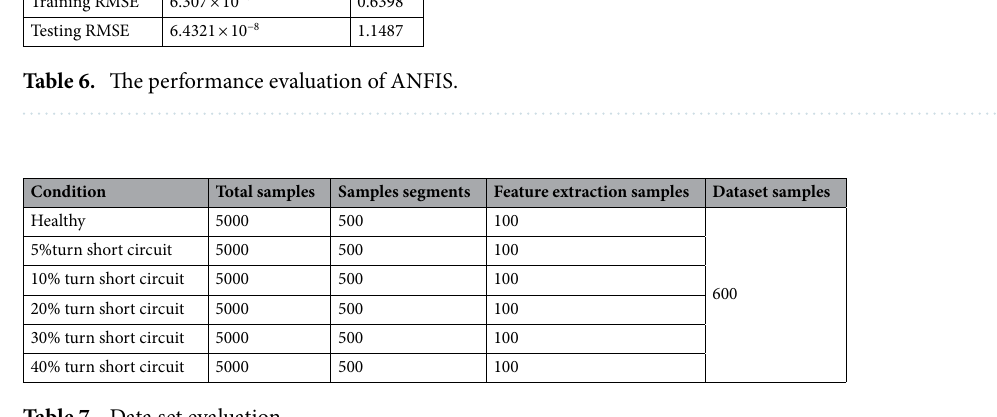
Table 7. Data set evaluation.